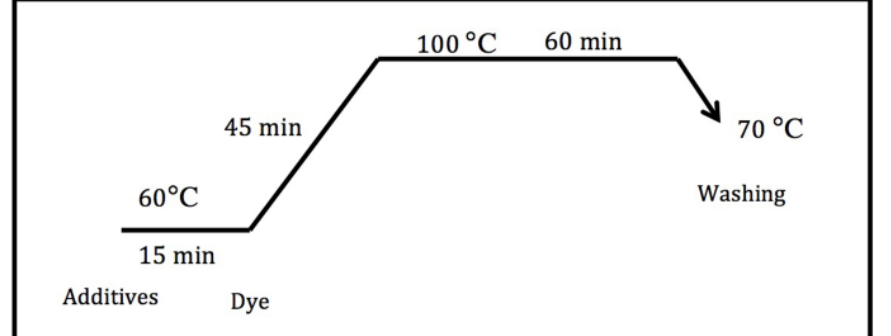
Figure 3. Exhaustion dyeing